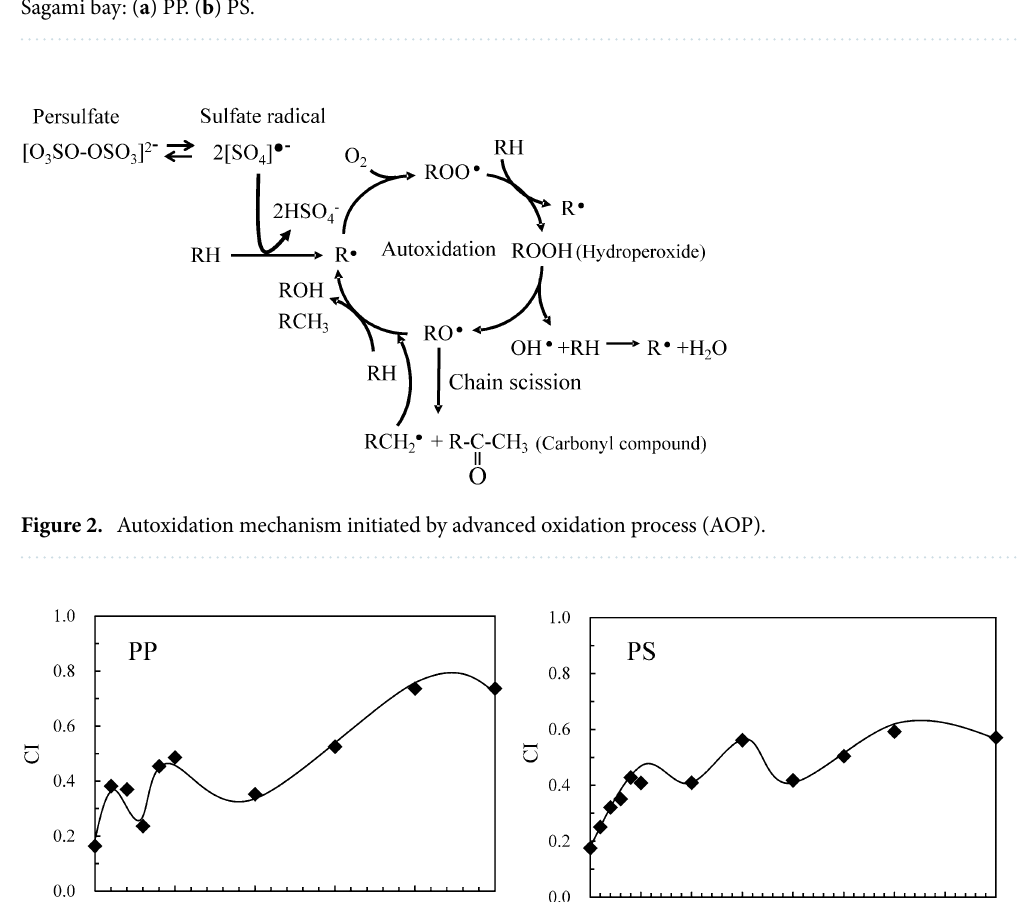
Figure 1. Optical microphotographs of PP and expanded PS (EPS) samples retrieved from beaches on the Sagami bay: ( a ) PP. ( b ) PS.